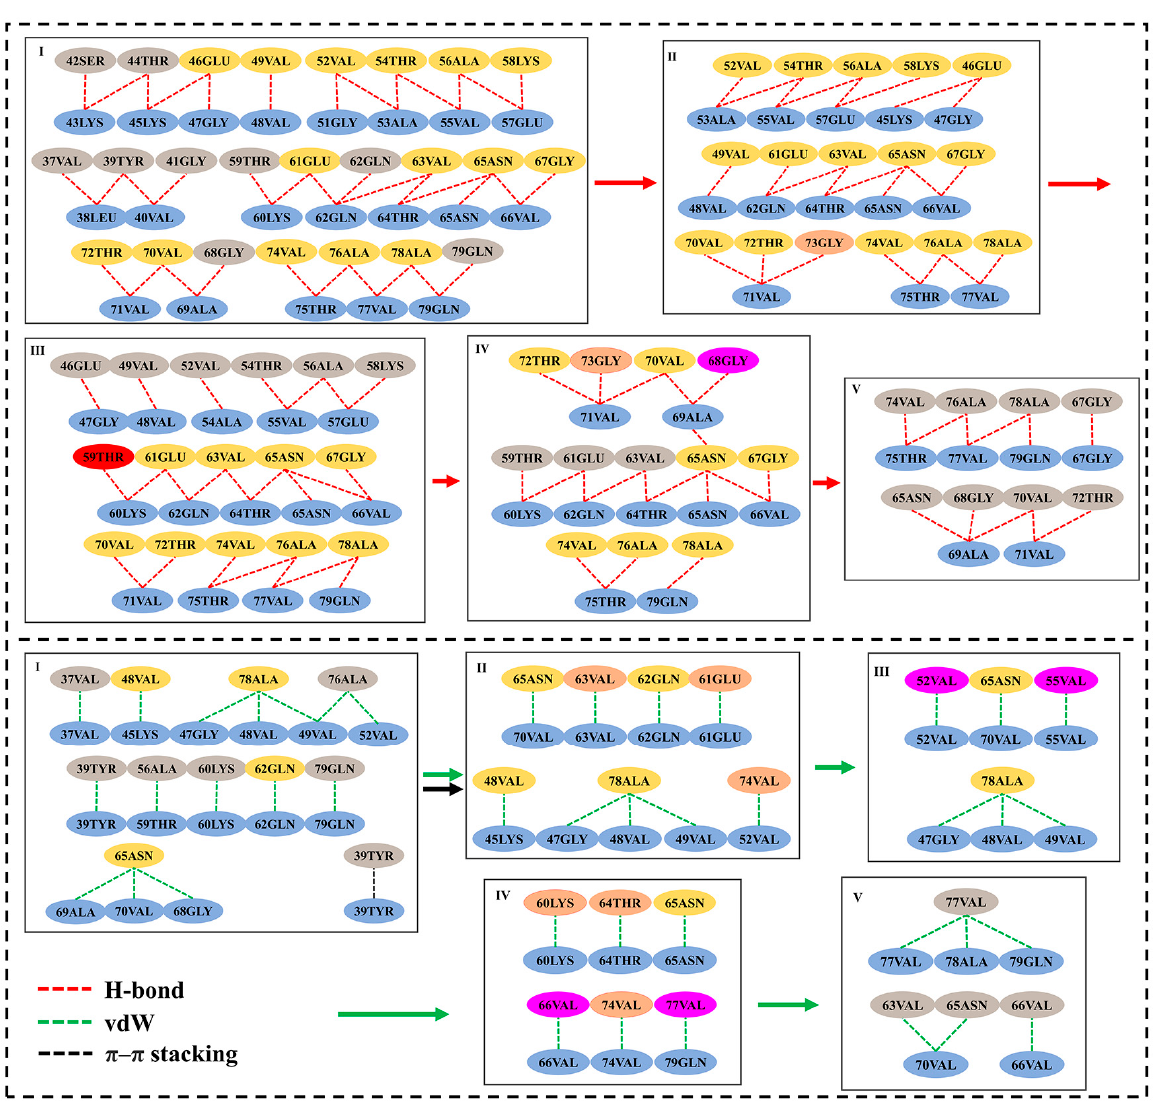
Figure 5. The residue interaction network analysis for human brain system. The yellow and blue ovals represent the residues of Chain-1 and Chain-2, respectively. The gray ovals indicate the residue to be dissociated at the present stage. Magenta ovals represent residues with increased interactions compared to the previous stage. The pink ovals represent residues with increased interaction compared to the previous stage but with dissociation compared to the next stage. The red ovals represent the residues that disappeared in the previous stage but reappeared in this stage. The red, green, black dash lines represent H-bond, vdW, and π – π interactions, respectively. The red, green, black arrows represent the processes of H-bond, vdW, and π – π interactions from one stage to another, respectively.